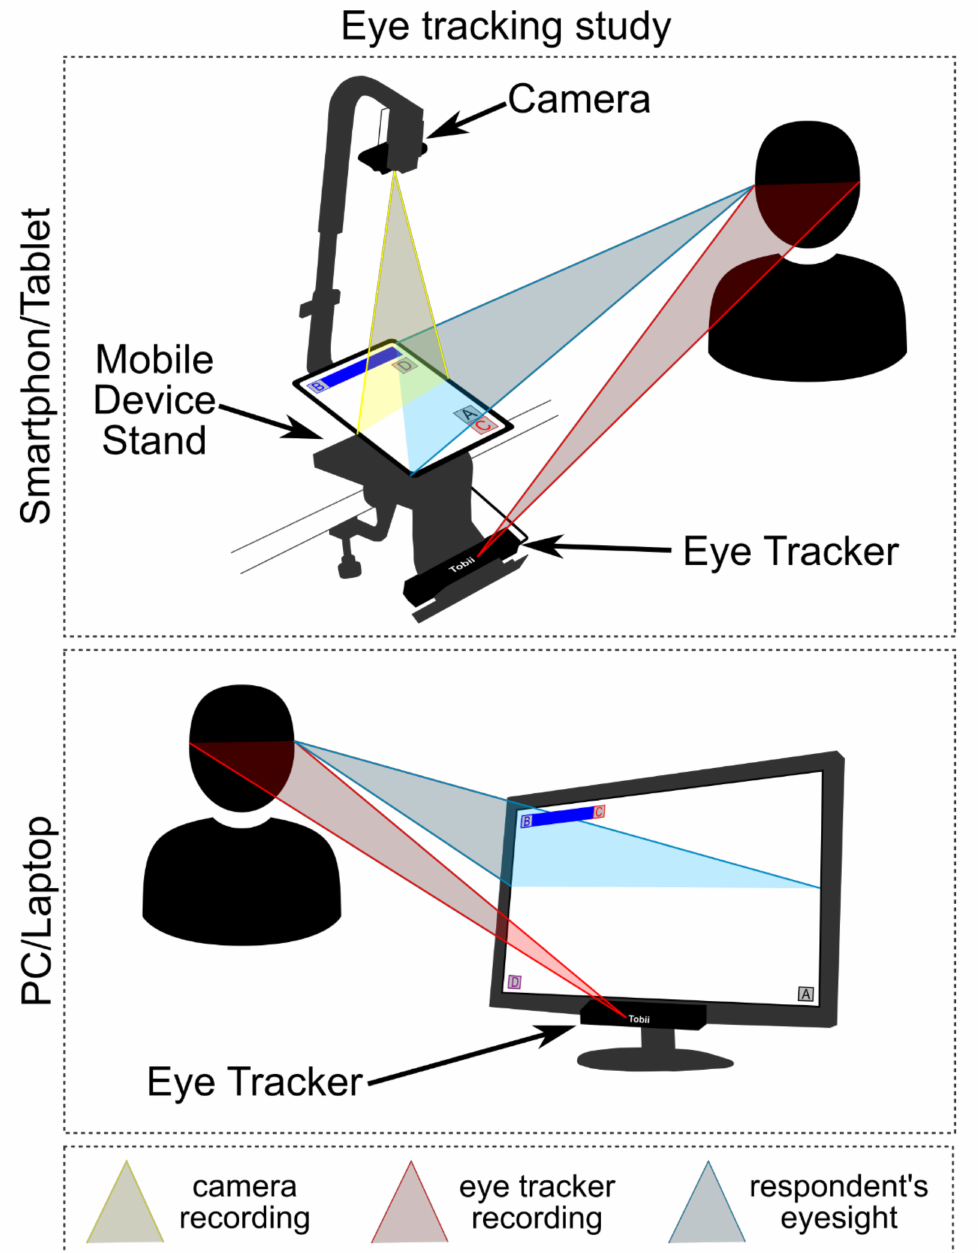
Figure 3. The method of conducting the eye-tracking study with a smartphone and PC